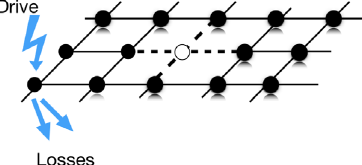
FIG. 18. Sketch of the quantum cavity method to derive the effective action of DMFT for Markovian lattice problems (see the text). A given lattice site is singled out (white dot in the figure), and all the remaining degrees of freedom are integrated out. Because of the coupling between the site and its 2 z neighbors (dashed lines), this integration of degrees of freedom reduces to evaluating correlation function of a lattice with a cavity, con- taining all the remaining